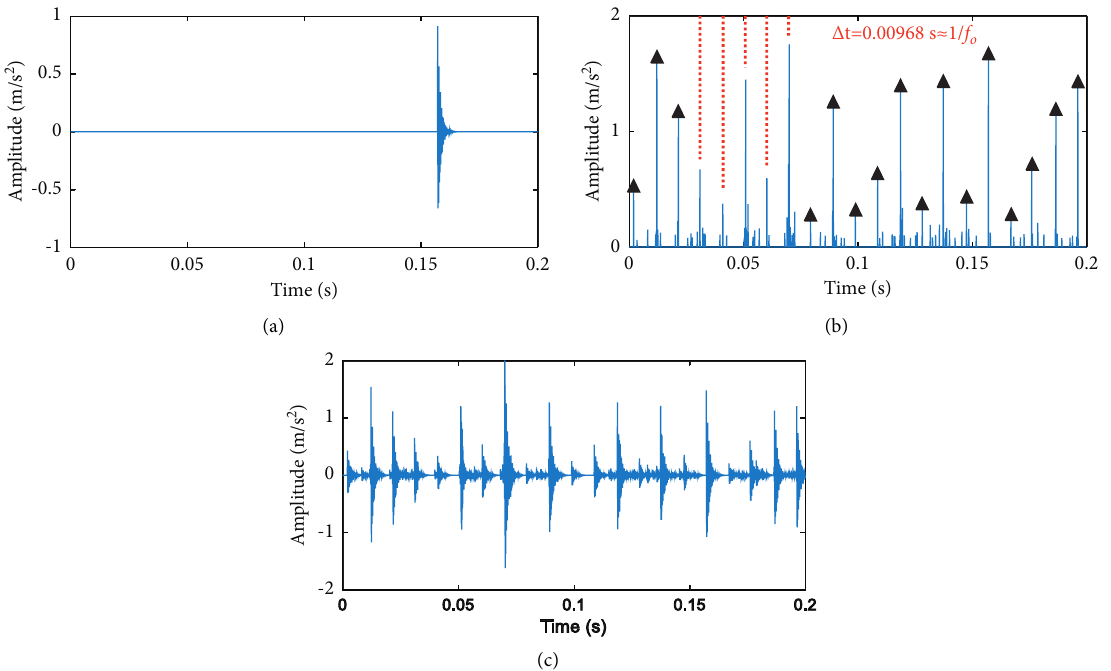
Figure 12: The results of sparse representation of the vibration signal of the weak failure of the outer ring of the bearing. (a) The optimal Laplace wavelet atom. (b) Sparse representation coefficients. (c) The reconstructed signal.